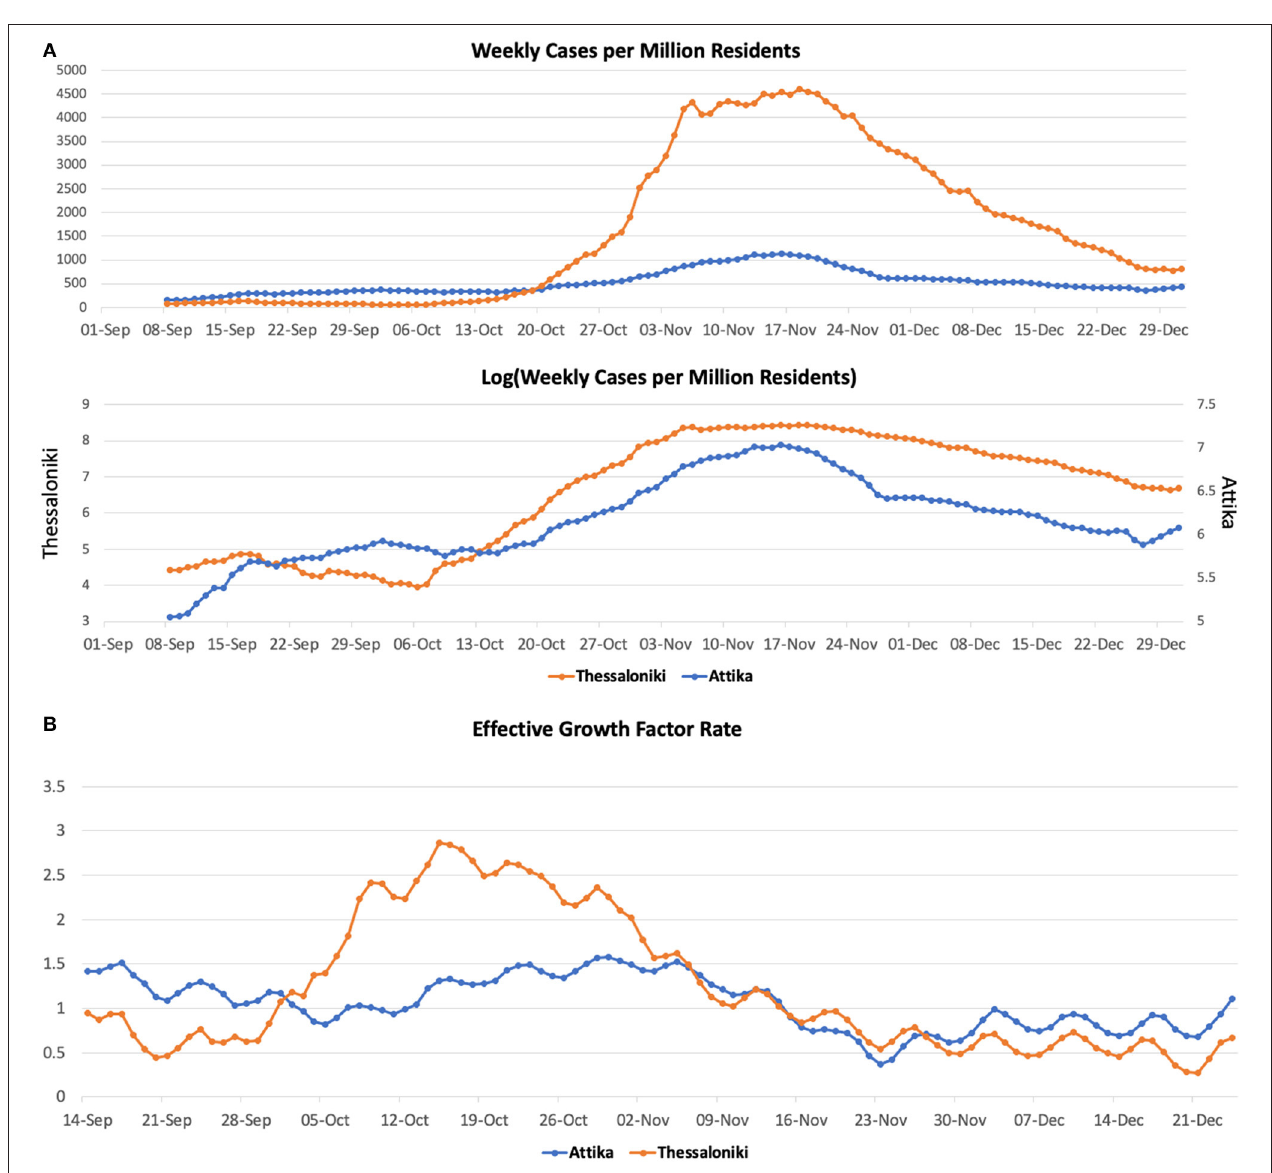
FIGURE 2 | COVID-19 cases (A) and effective growth factor (B) in Attika and Thessaloniki between June 2020 and January